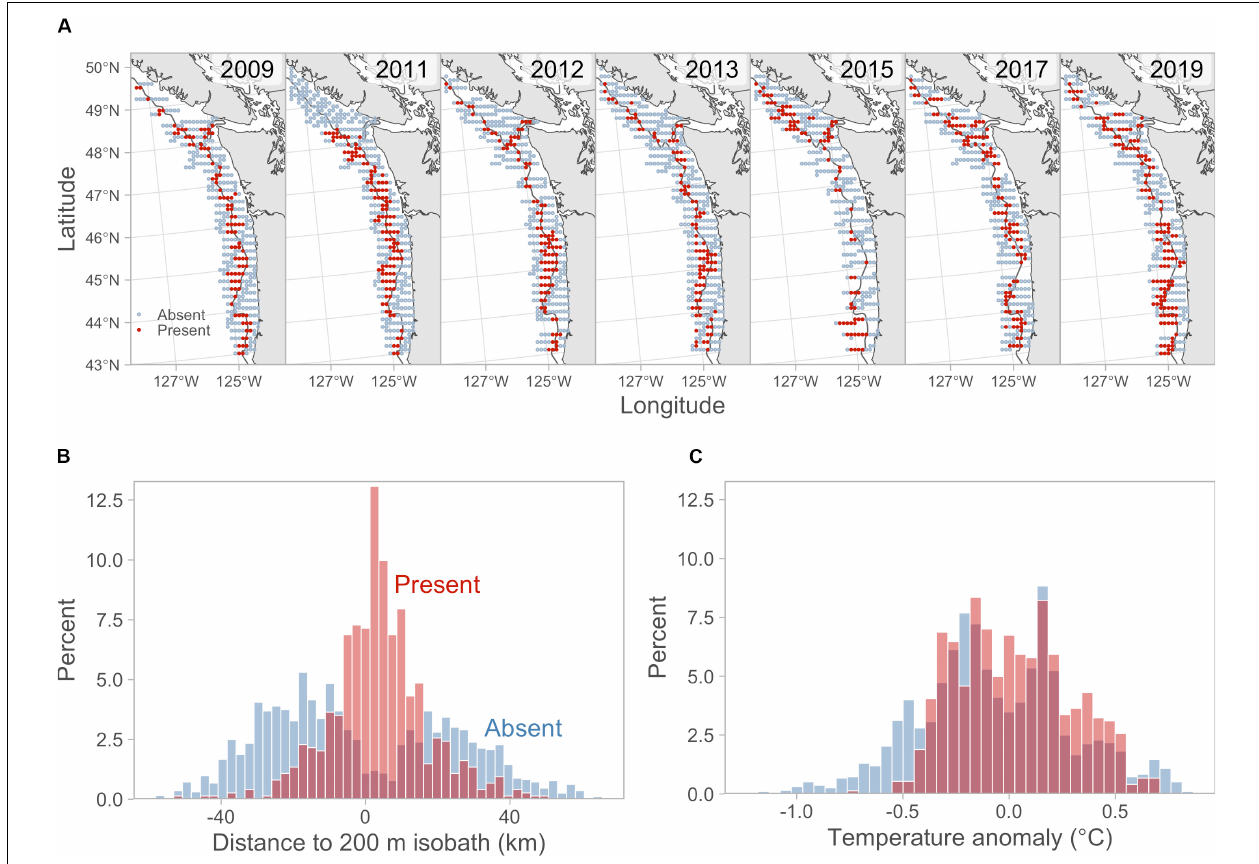
FIGURE 1 | Pacific hake summer distribution as determined by acoustic-trawl surveys. (A) Annual occurrences and absences of Pacific hake across the study region. Solid red circles indicate hake occurrences and open blue circles indicate hake absences. Solid gray lines show the 200 m isobath. (B) Histograms of distance to the 200 m isobath for Pacific hake occurrences (red) and absences (blue). Darker red bars indicate overlap between the occurrences and absences. (C) Histograms of temperature anomaly at 250 m depth for Pacific hake occurrences (red) and absences (blue). Temperature anomalies are reforecasts from the J-SCOPE